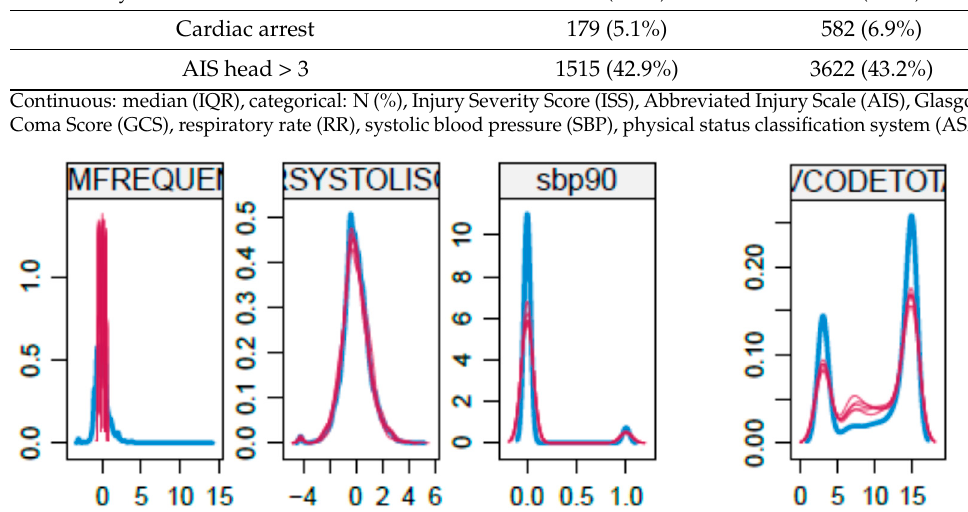
Figure A1. Density plots of continous variables with missing values of multiple imputed datasets.